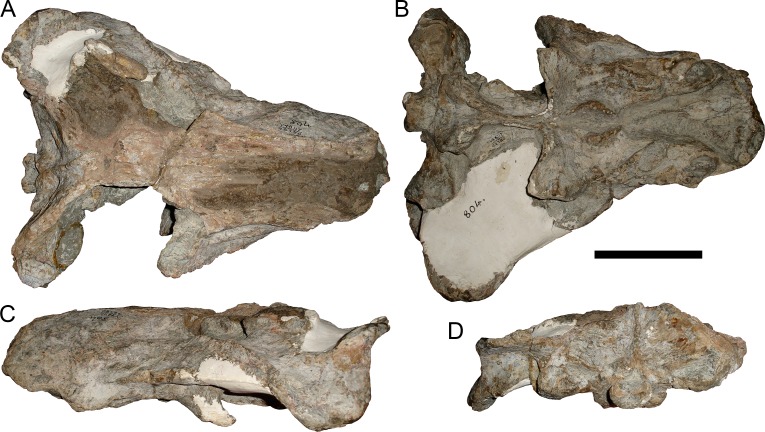
Referred specimen (UCMP 42750) of Leontosaurus vanderhorsti
Broom & George, 1950 in (A) dorsal, (B) ventral, (C) left lateral, and (D) occipital view.Scale bar equals 10 cm.